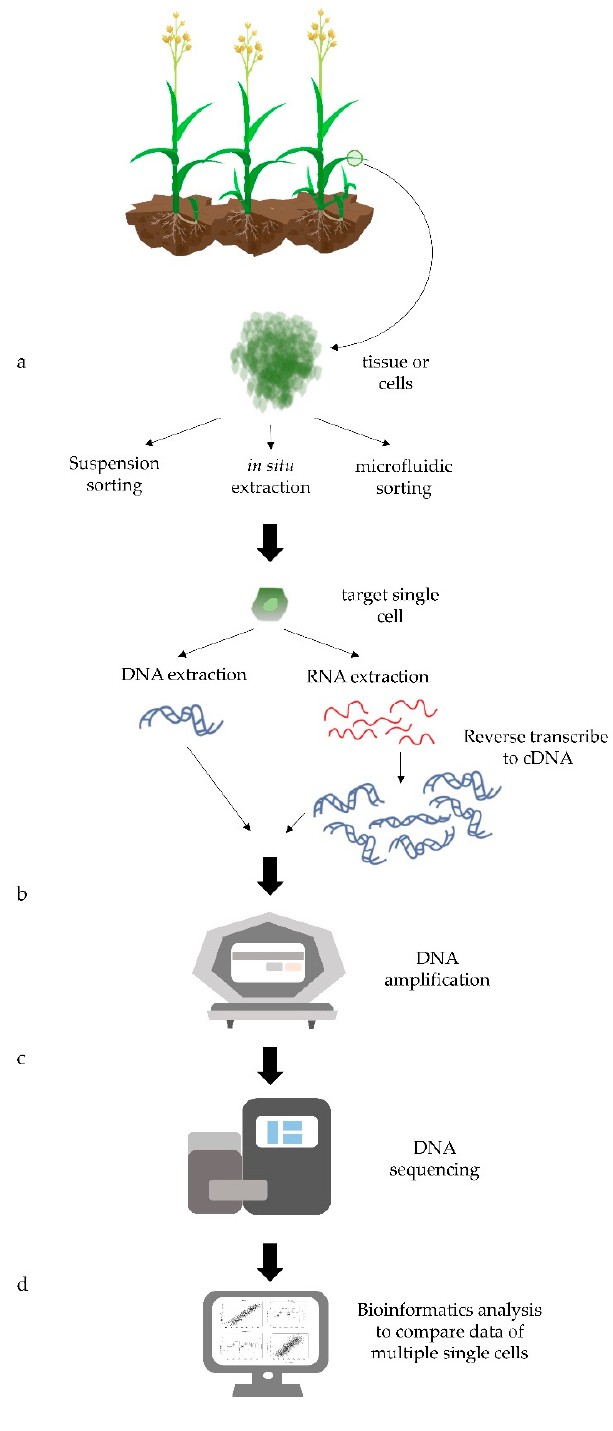
Figure 1. Overview of plant single-cell genomic analysis. ( a ) During single-cell preparation, target single cells are isolated in a suspension, extracted mechanically in situ, or sorted by microfluidics. After single-cell isolation, DNA or RNA is extracted. RNA is reverse transcribed to single stranded or double stranded cDNA (only double stranded cDNA shown). ( b ) To increase the amount of material for sequencing, DNA or cDNA (when studying transcripts) are amplified. ( c ) Libraries are prepared for genomic DNA or cDNA and next-generation sequencing is carried out. ( d ) Bioinformatics analysis is conducted to compare single-cell sequences and find functional variants between cells.